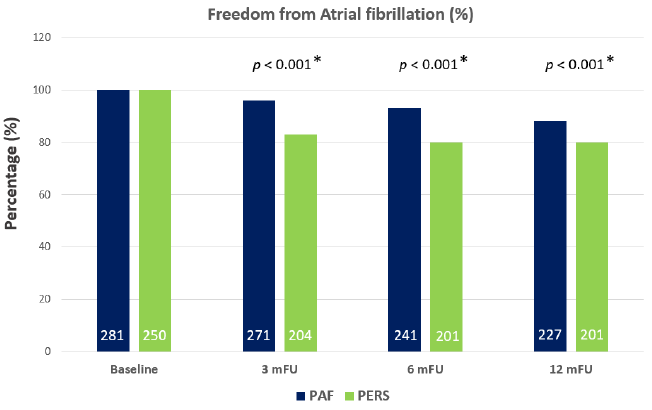
Figure 1. Freedom from AF/AT recurrence (%) in patients with PAF and PERS. AF, atrial fibrillation; AT, atrial tachyarrhythmia; PAF, paroxysmal atrial fibrillation; PERS, persistent atrial fibrillation; mFU, months follow-up; p , p -value; * indicates statistical significance.